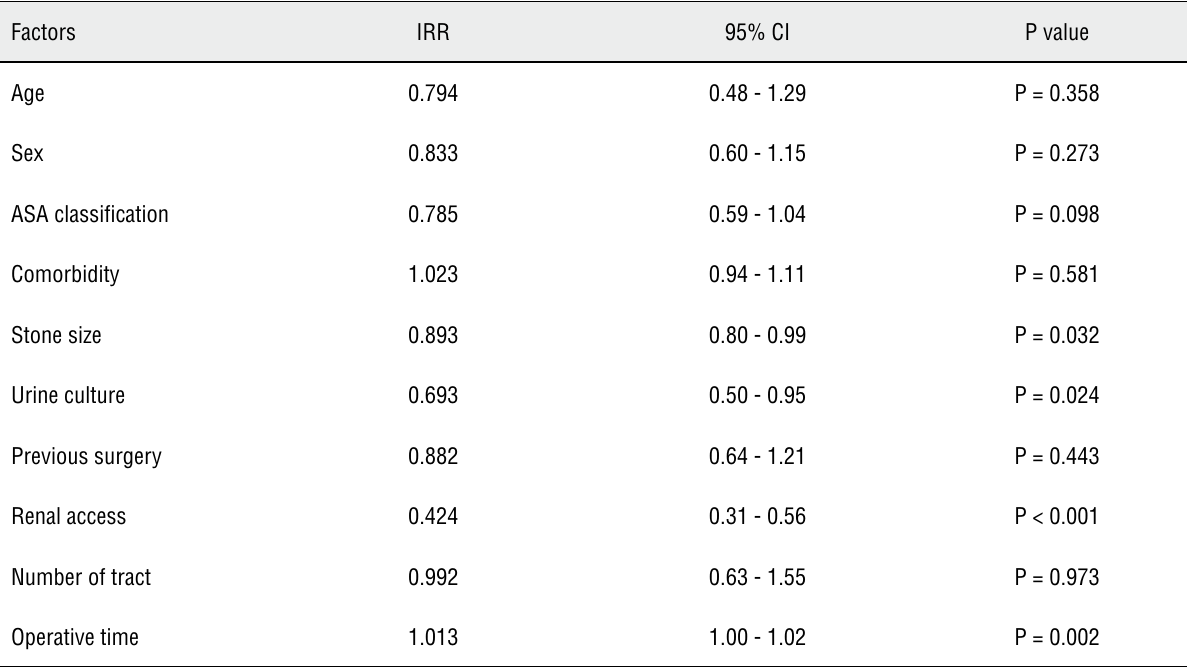
Table 6 - Multivariate analysis of complication rate in association with demographics, stone, pre-operative and operative